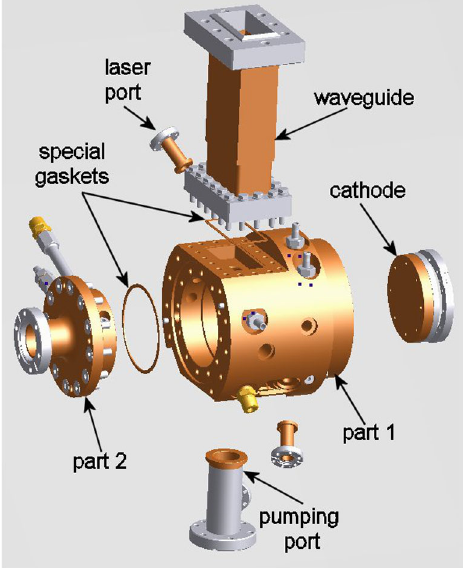
FIG. 6. Mechanical drawing of the gun: detail of the assembly procedure.